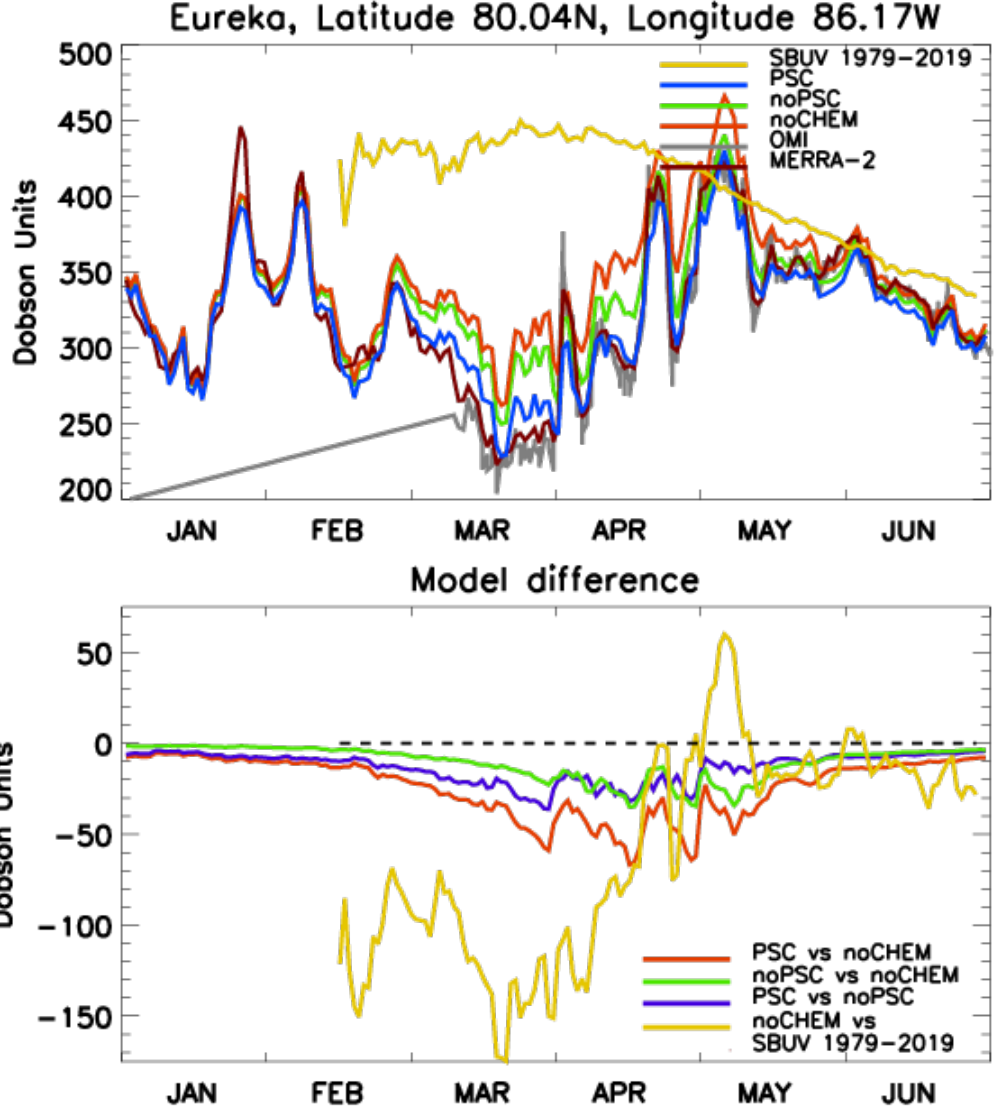
Figure 10. Column Ozone variability at Eureka Station for the first half of 2020 ( top ): SBUV mean over 1979–2019 (yellow), OMI data (gray), CTM basic scenario (PSC) (blue), CTM scenario without PSC processes included (noPSCaer) (green), CTM scenario with no chemical ozone destruction included (noCHEMall) (red); and column ozone difference between CTM simulation for several scenarios ( bottom ): noCHEMall and SBUV 1979–2019 averages (yellow), PSC and noCHEMall (red), and PSC and noPSCaer (blue).